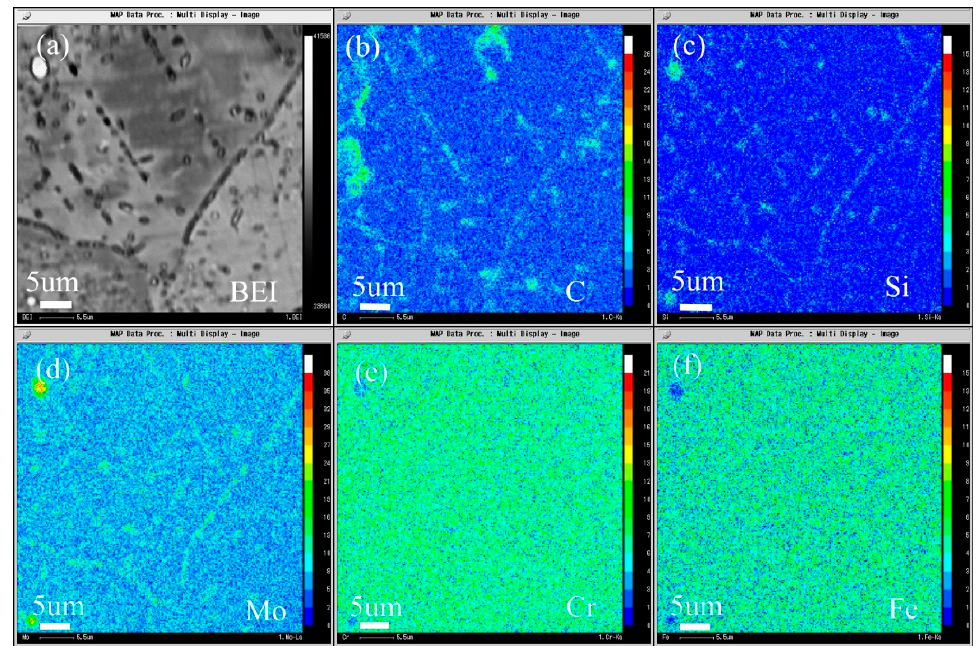
Figure 18. Microstructure of the 0.011C specimen aged at 900 ◦ C for 2 h: ( a ) BEI image and the area distribution of ( b ) C, ( c ) Si, ( d ) Mo, ( e ) Cr, and ( f ) Fe by